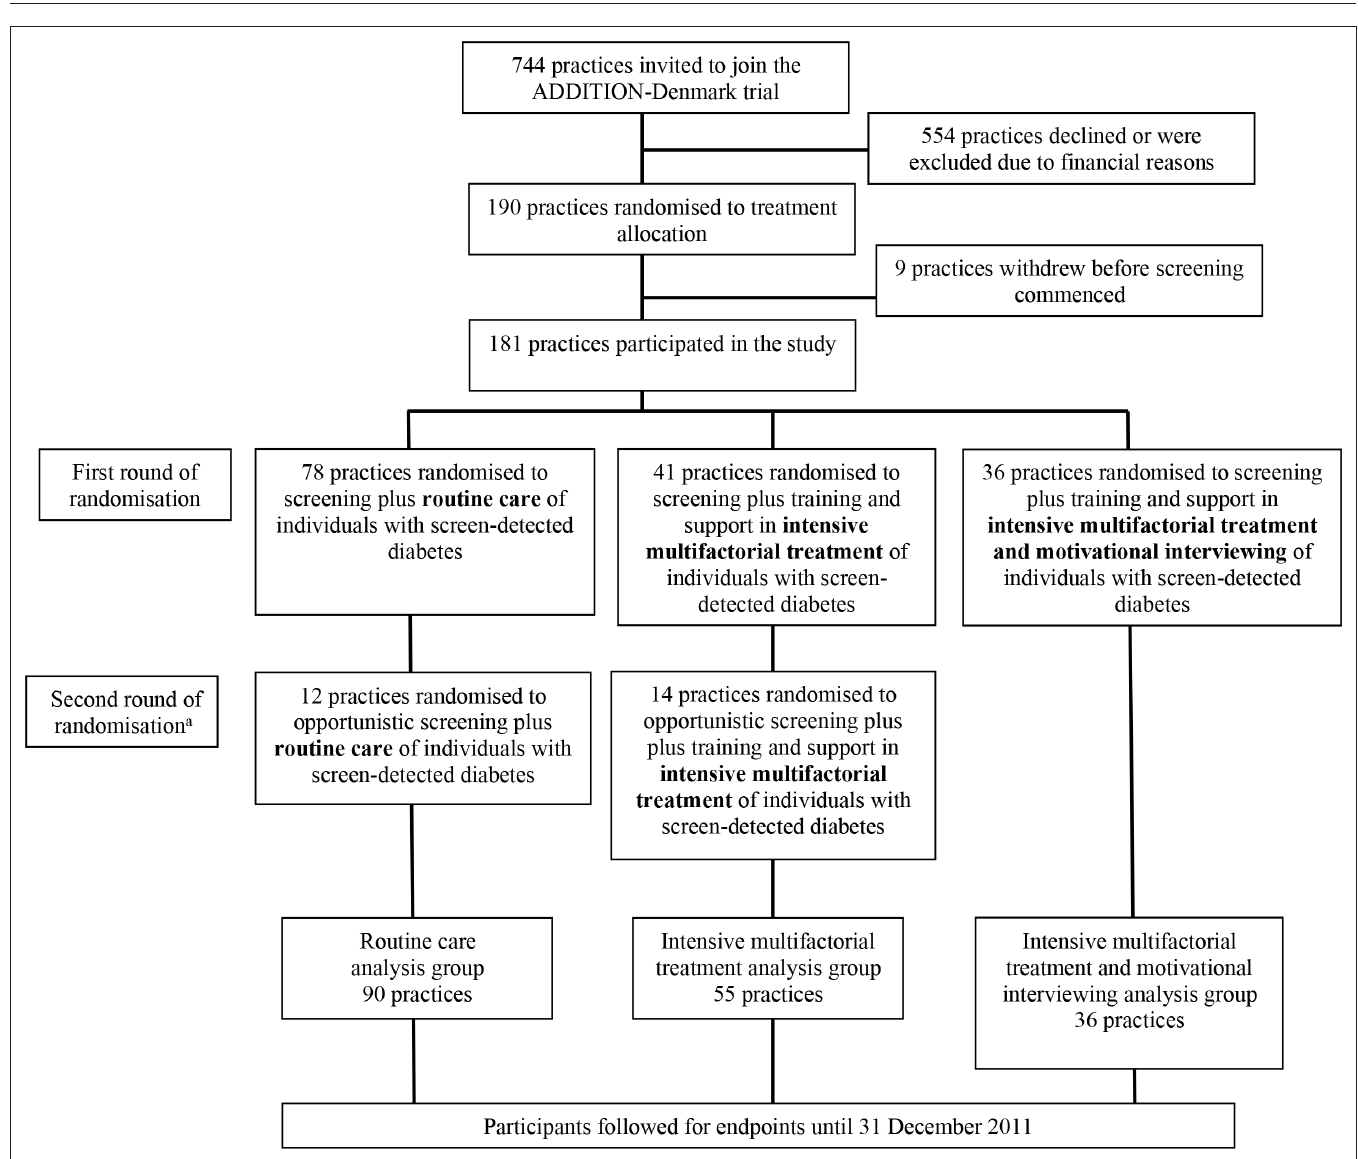
Figure 1 Practice and participant flow in the ADDITION- Denmark trial. a Owing to restricted resources, a second round of 26 practices were randomised to opportunistic screening plus routine care or opportunistic screening plus intensive